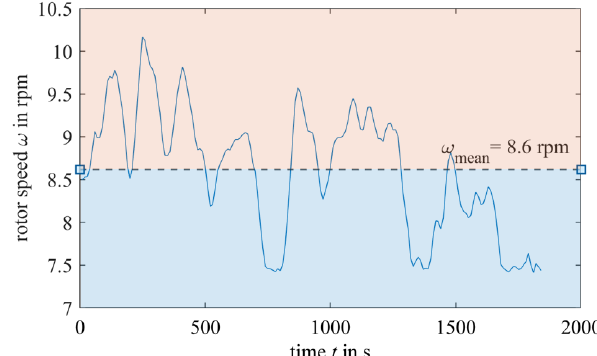
Figure 12. Measured rotor speed ω over the measurement time with ω mean = 8 . 6rpm. Each scanned rotor blade is categorized into higher wind loads ( ω > ω mean ) shaded in orange or lower wind loads ( ω ≤ ω mean ) shaded in blue.